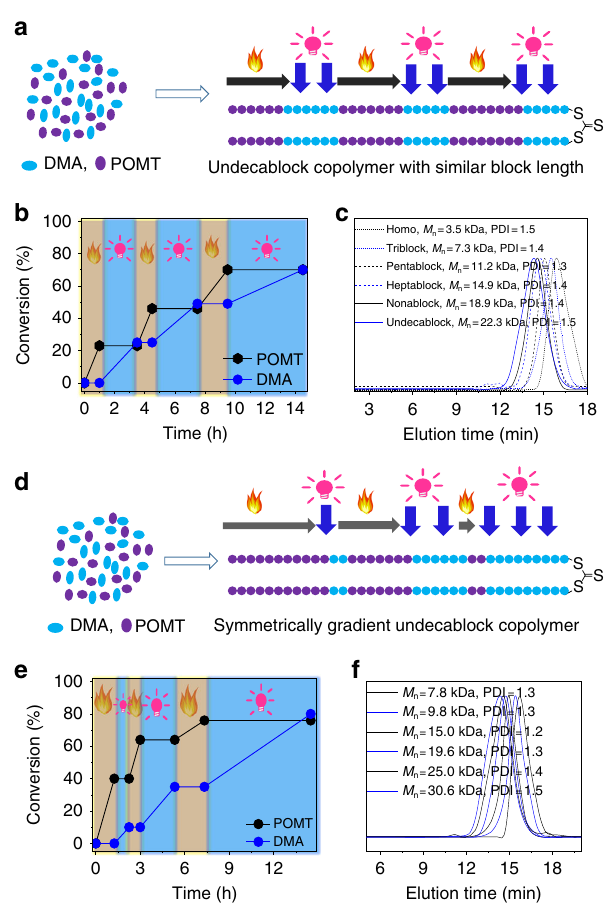
Fig. 4 Synthesis of multiblock copolymer by multiple cycles of heating followed by irradiation. a Outline of formation of undecablock copolymer with similar block length. b Monomer conversion versus polymerization time for synthesis of undecablock copolymer with similar block. c SEC curves for resulting polymers at different polymerization time. d Outline of formation of symmetrically gradient undecablock copolymer. e Monomer conversion versus polymerization time for synthesis of symmetrically gradient undecablock copolymer. f SEC curves for resulting polymers at different polymerization